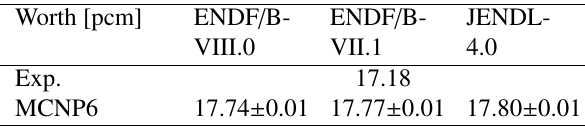
Table 5. Control rod worth for di ff erent nuclear data libraries